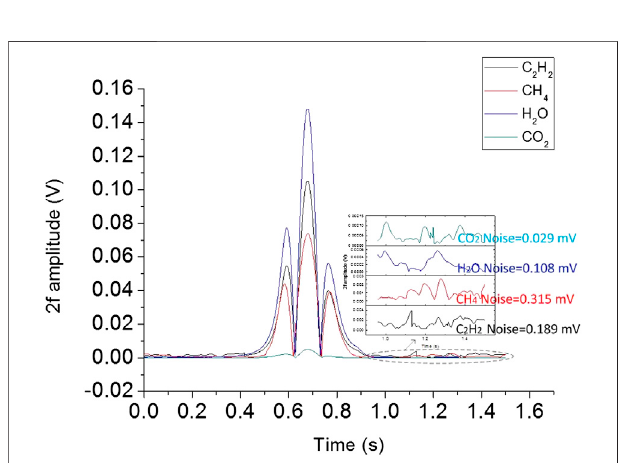
FIGURE 4 | PAS signals and noises of C2H2, CH4, H2O and